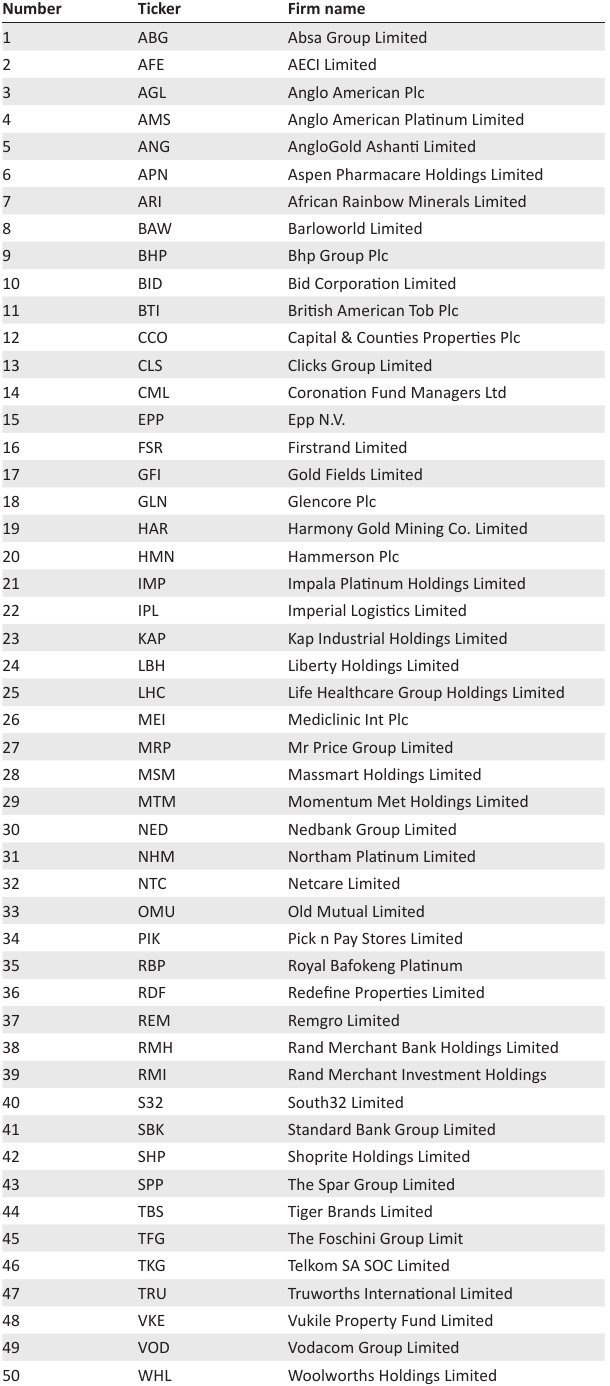
TABLE 1-A1: The list of 50 JSE-listed